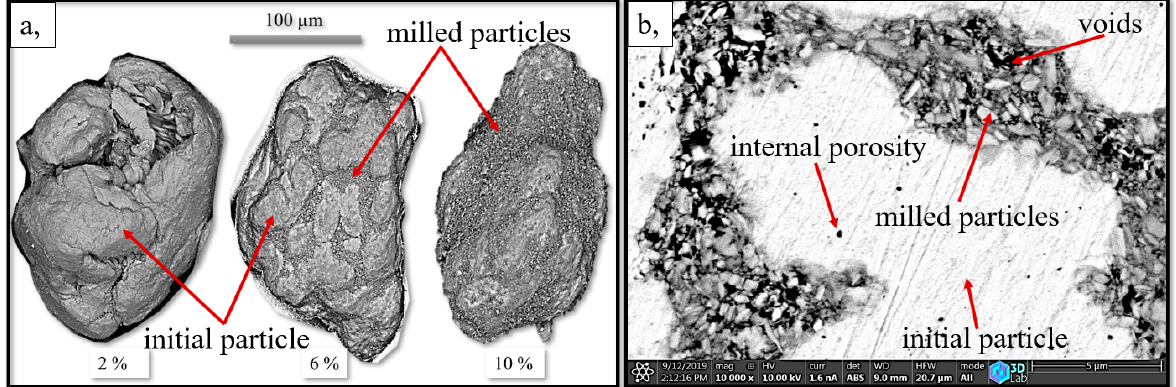
Figure 2. ( a , b ) Show the morphology of the initial and the milled Ti powders, respectively. Table 2. Chemical composition of initial and milled Ti powder (wt.%).